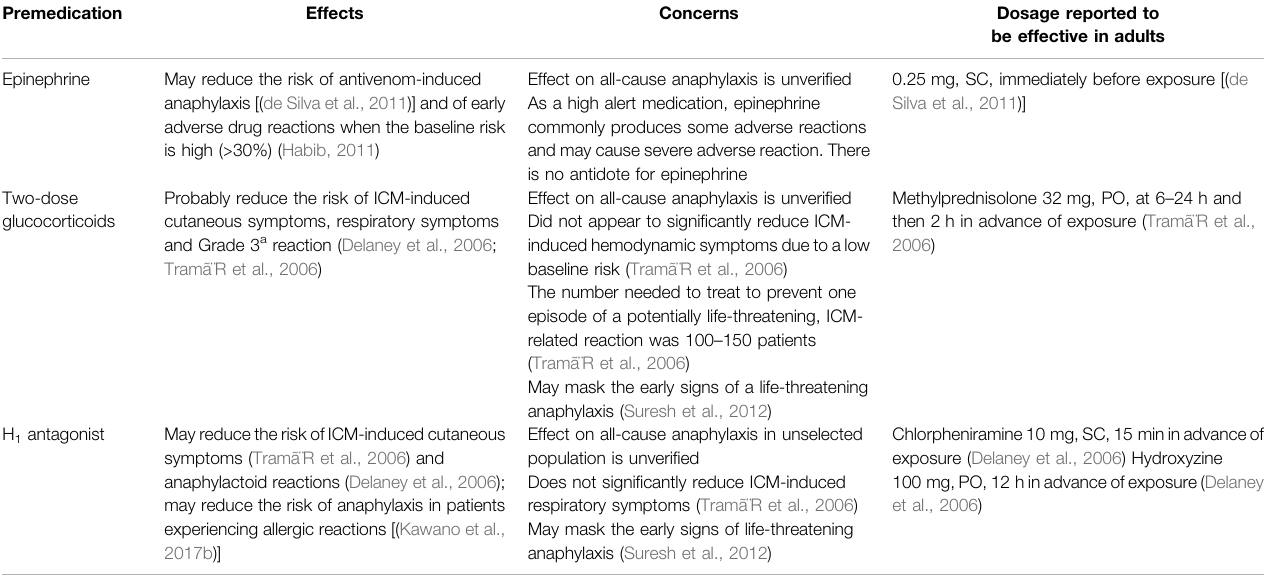
TABLE 6 | Summary of potential anaphylaxis preventive medication and their